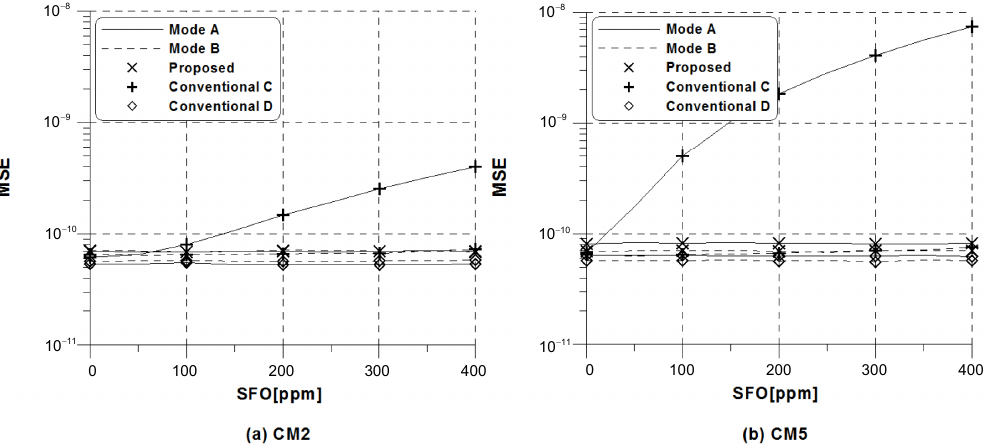
Figure 4. MSE of the conventional and proposed frequency estimators versus sampling frequency offset (SFO) for DRM modes A and B when signal-to-noise ratio (SNR) = 25 dB.